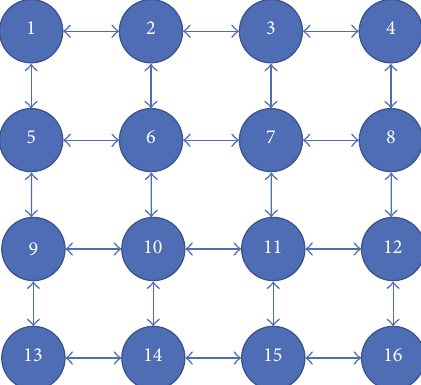
Figure 5: The LUT resource utilization of CONNECT, SOTA, and the interconnect system implemented in this paper. Figure 6: The pattern for the static part of the hybrid